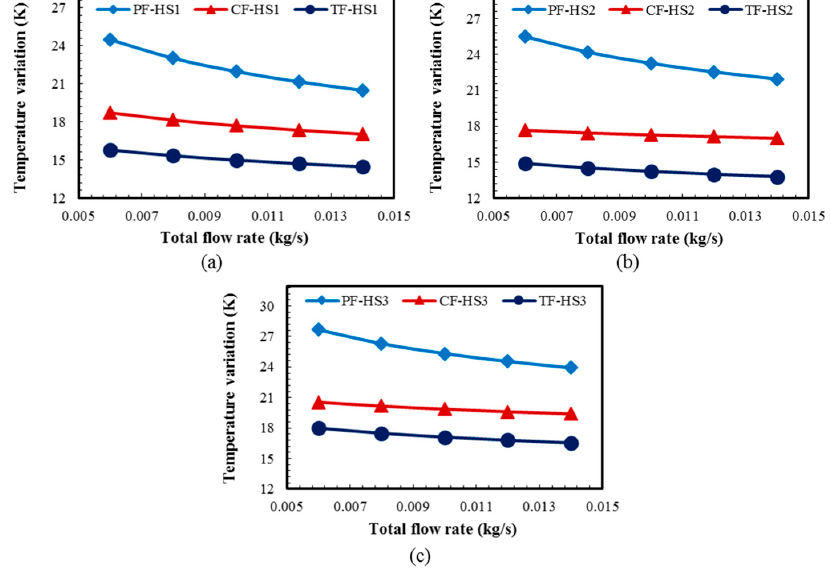
Figure 13. Temperature variation among the hotspots for different total flow rates for the PF, CF, and TF heat sinks (total flow rate varied from 0.006 to 0.014 kg/s): ( a ) HS1; ( b ) HS2; and ( c ) HS3.